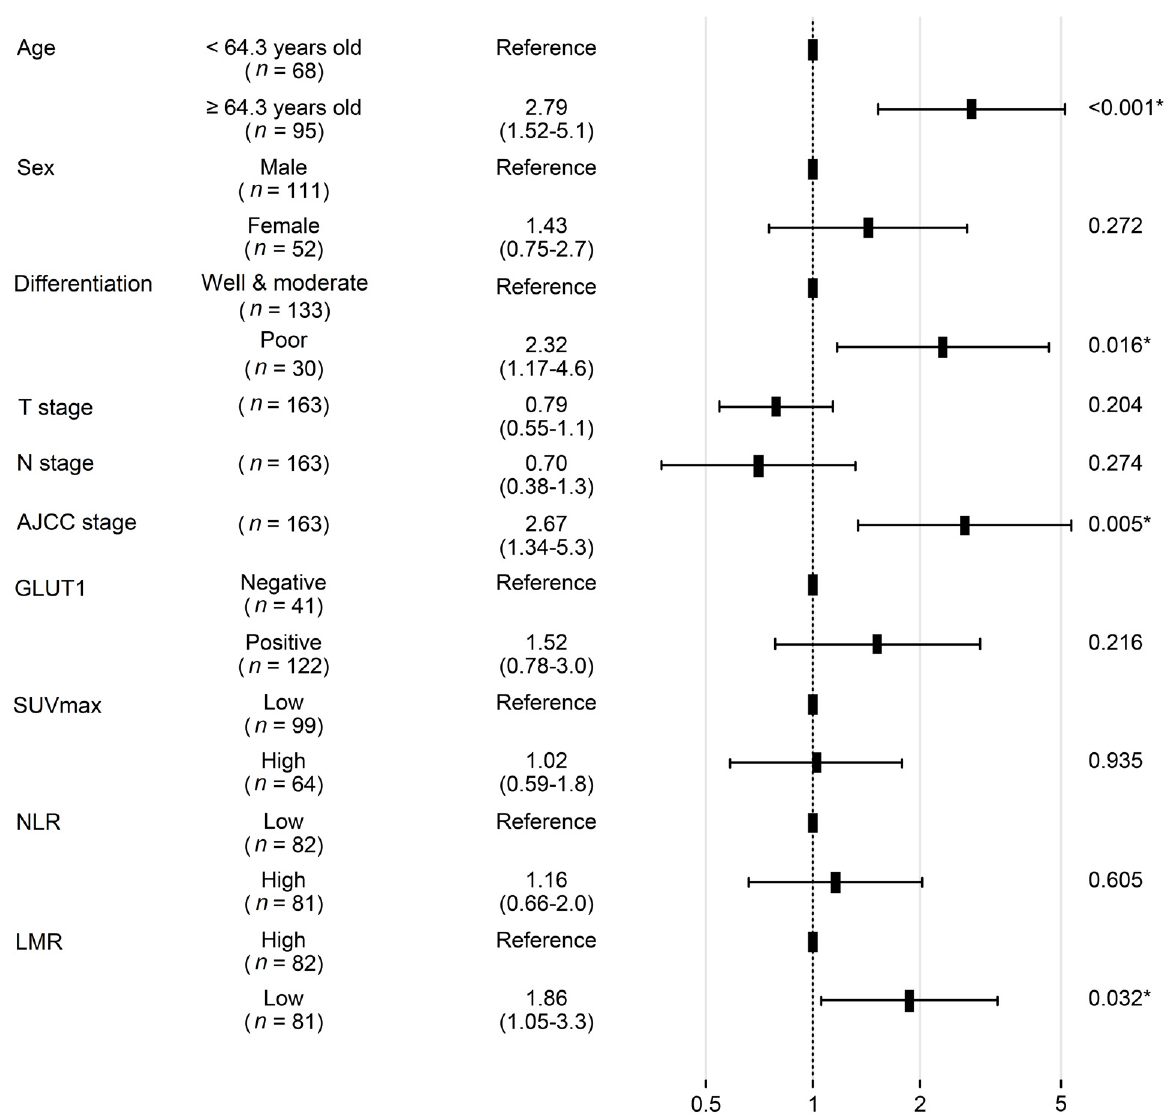
Figure 3. Forest plot showing hazard ratios obtained by multivariate Cox regression for overall sur- vival in patients with non-small cell carcinoma. SUV max , fluoro-D-glucose-positron emission tomog- raphy maximum uptake value; NLR—neutrophil–lymphocyte ratio; LMR—lymphocyte–monocyte ratio. * Indicates factors with significant p values.